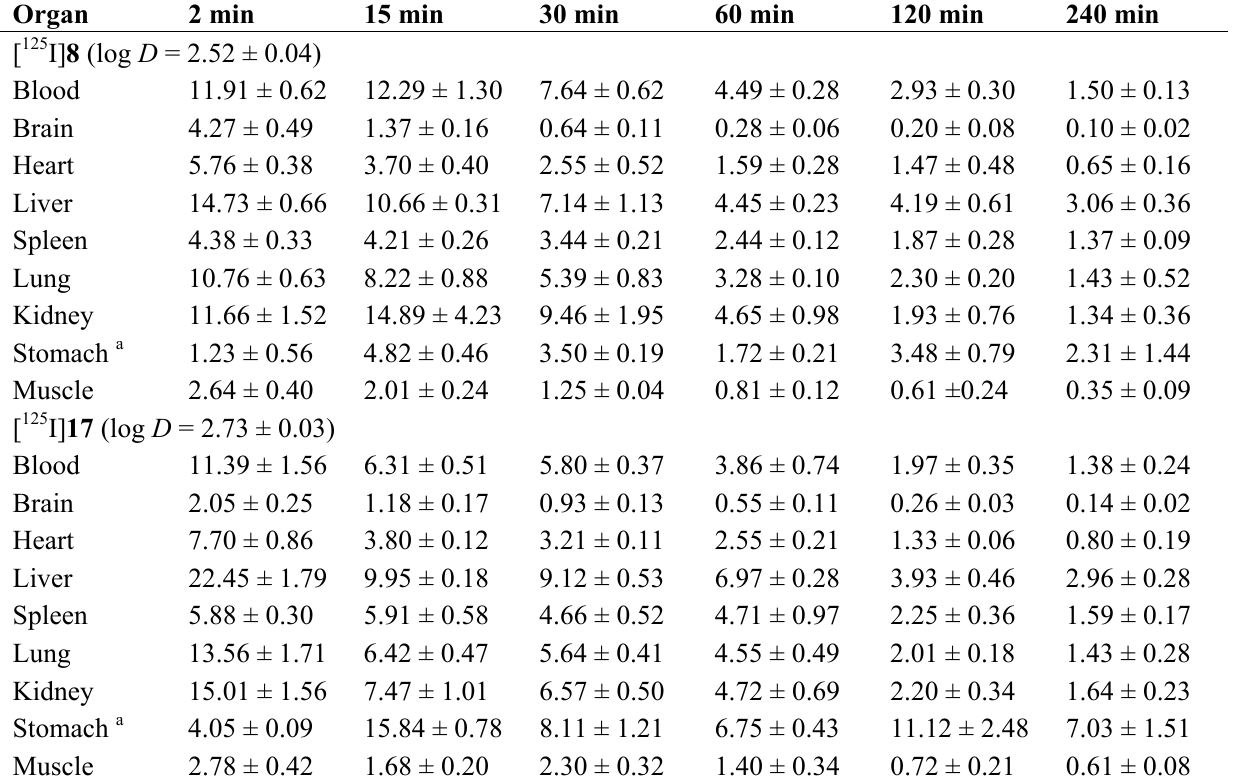
Table 2. Biodistribution in normal mice after iv injection of [ 125 I] 8 and [ 125 I] 17 (% ID/g, avg of 5 mice ± SD) and its partition coefficient